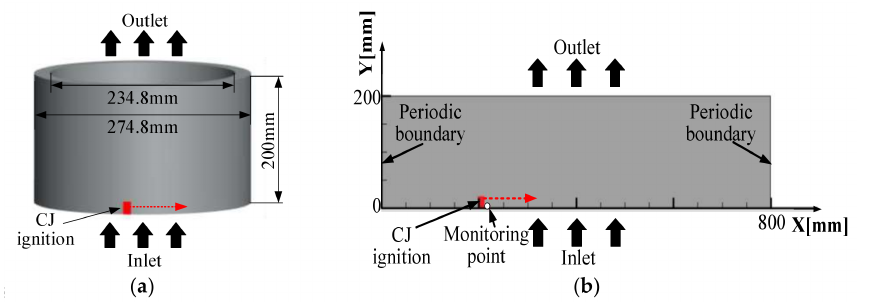
Figure 1. ( a ) Three-dimensional geometric model; and ( b ) Two-dimensional computational domain of CRD combustors. CJ,